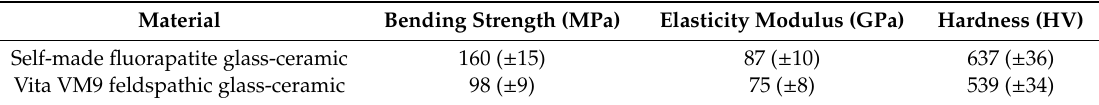
Table 1. Mechanical properties of the fluorapatite and feldspathic glass-ceramic (figures in brackets represent standard deviations).